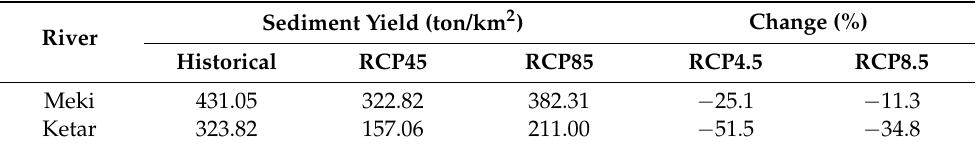
Table 5. Sediment yield estimation.